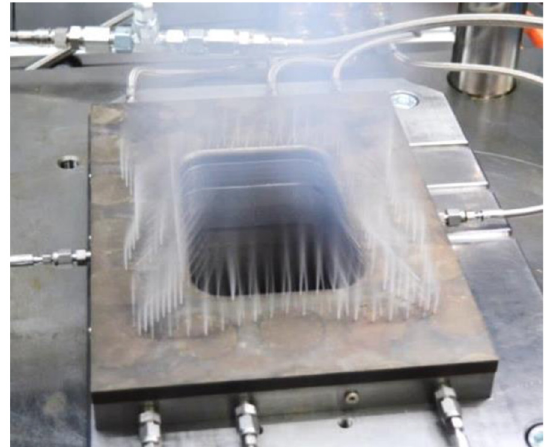
Fig. 17. Free fl ow out of the CO 2 through laser-drilled microholes in the die of the deep drawing tool.